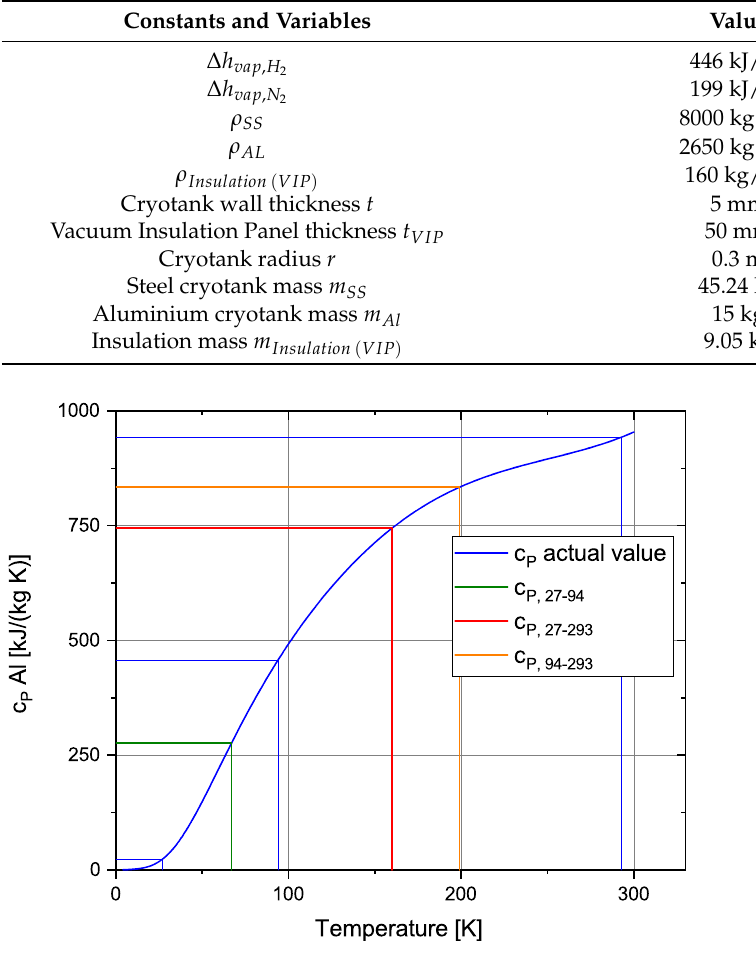
Figure 5. Average heat capacity cp